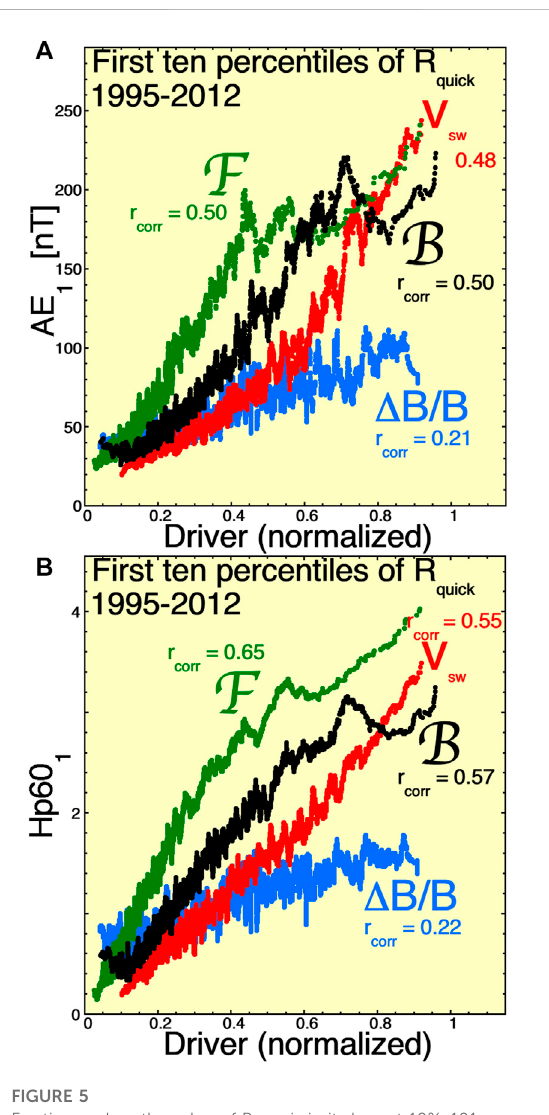
FIGURE 5 For times when the value of R quick is in its lowest 10%, 101- point running averages of AE 1 [panel (A) ] and Hp60 1 [panel (B) ] are plotted as functions of four “ drivers ” : Δ B/B (blue), v sw (red), F (green), and B